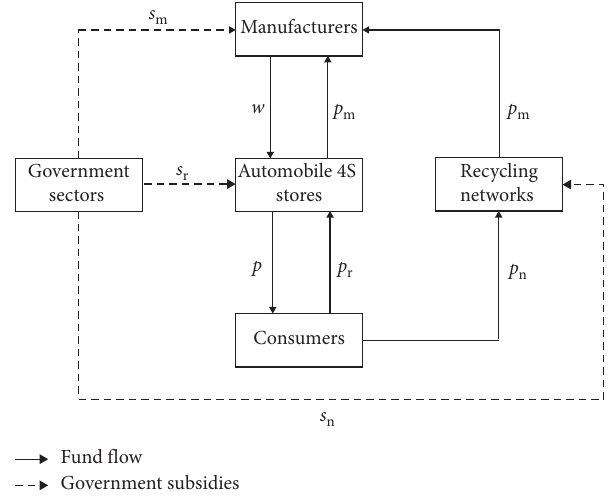
Figure 1: Flow chart of power battery recycling of new energy